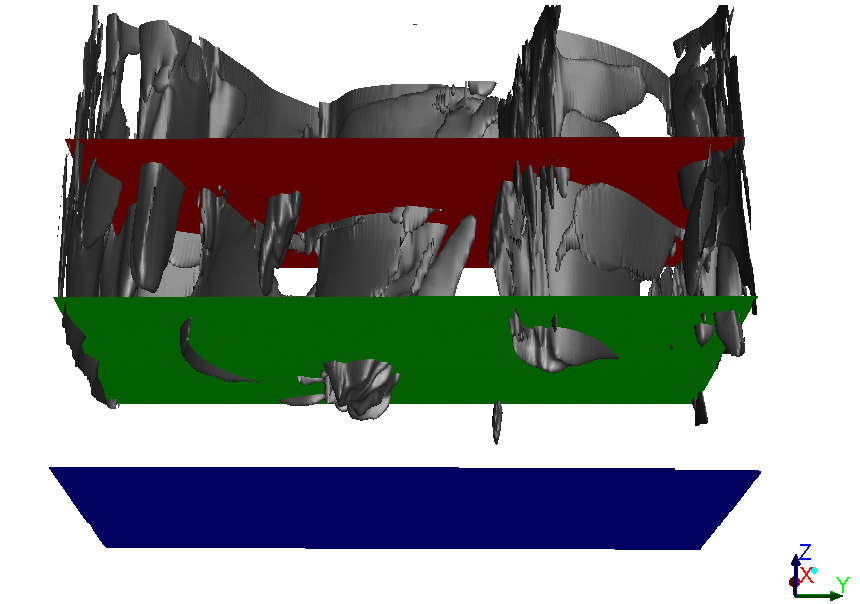
Figure 3. The submesoscale structures ( Ro = 1 iso-surface) within the mixed layer. The planes at the depths of 25 m (red), 50 m (green), and 75 m